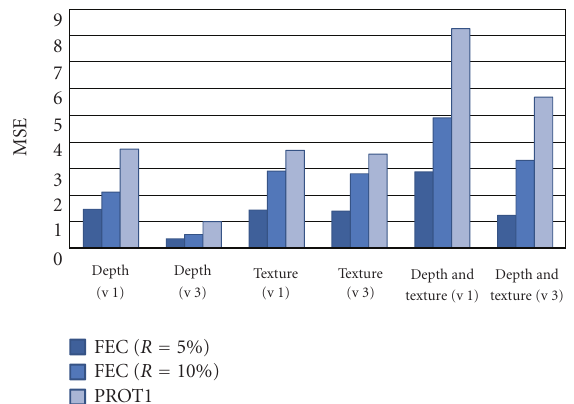
Figure 23: Loss of both depth and texture packets: distortion as a function of the packet loss rate with di ff erent error protection schemes (warping to viewpoint